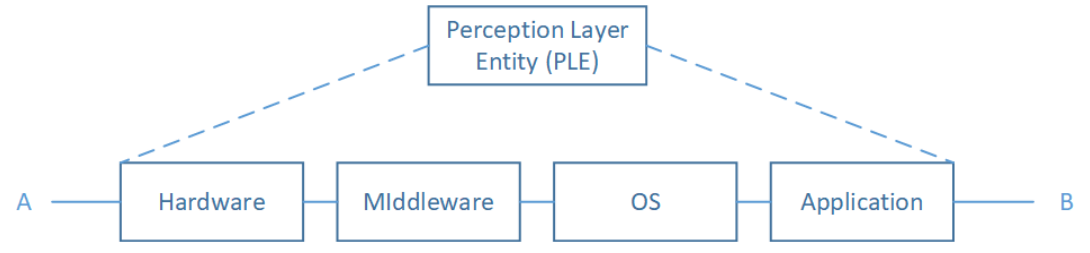
Figure 7. Perception Layer Entity RBD